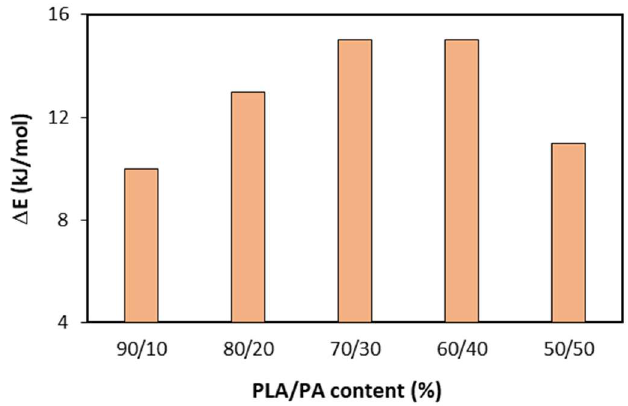
Figure 6. Increase in activation energy values ( ∆ E = E REX − E No REX ) when using reactive extrusion for bioblends containing 90–50% of PLA REX .